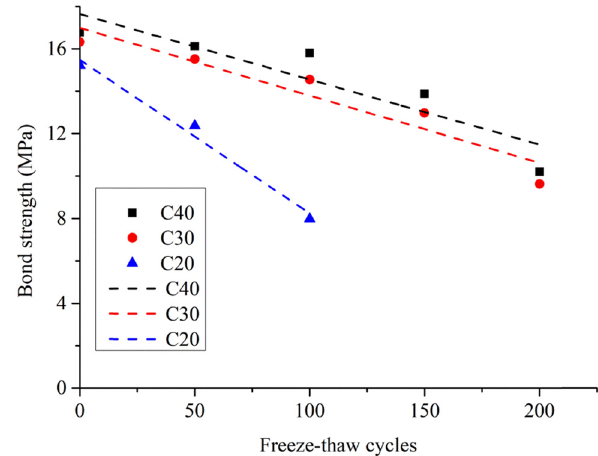
Figure 7: In fl uence of concrete strength on bond strength.